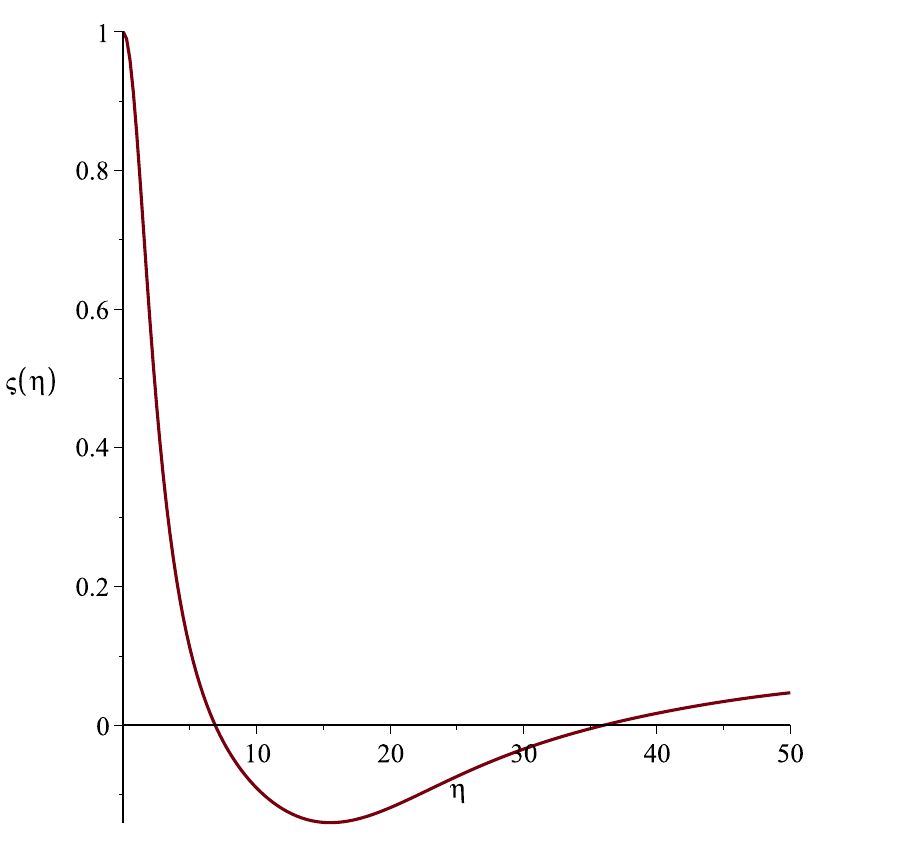
Figure 1. Numerical solution of Equation (1) obtained by the group preserving scheme (GPS). Table 1. Comparison of approximate solutions obtained by reproducing kernel method (RKM) and GPS for Equation